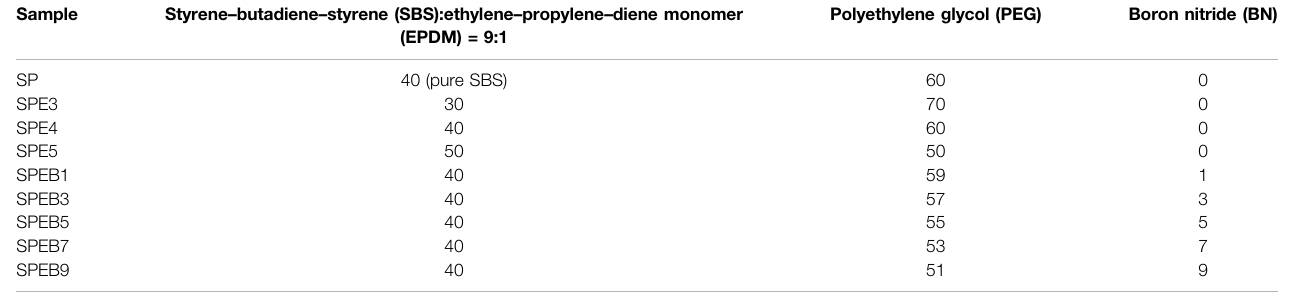
TABLE 1 | Various proportions of each component in composite phase-change material (CPCM) samples. Sample